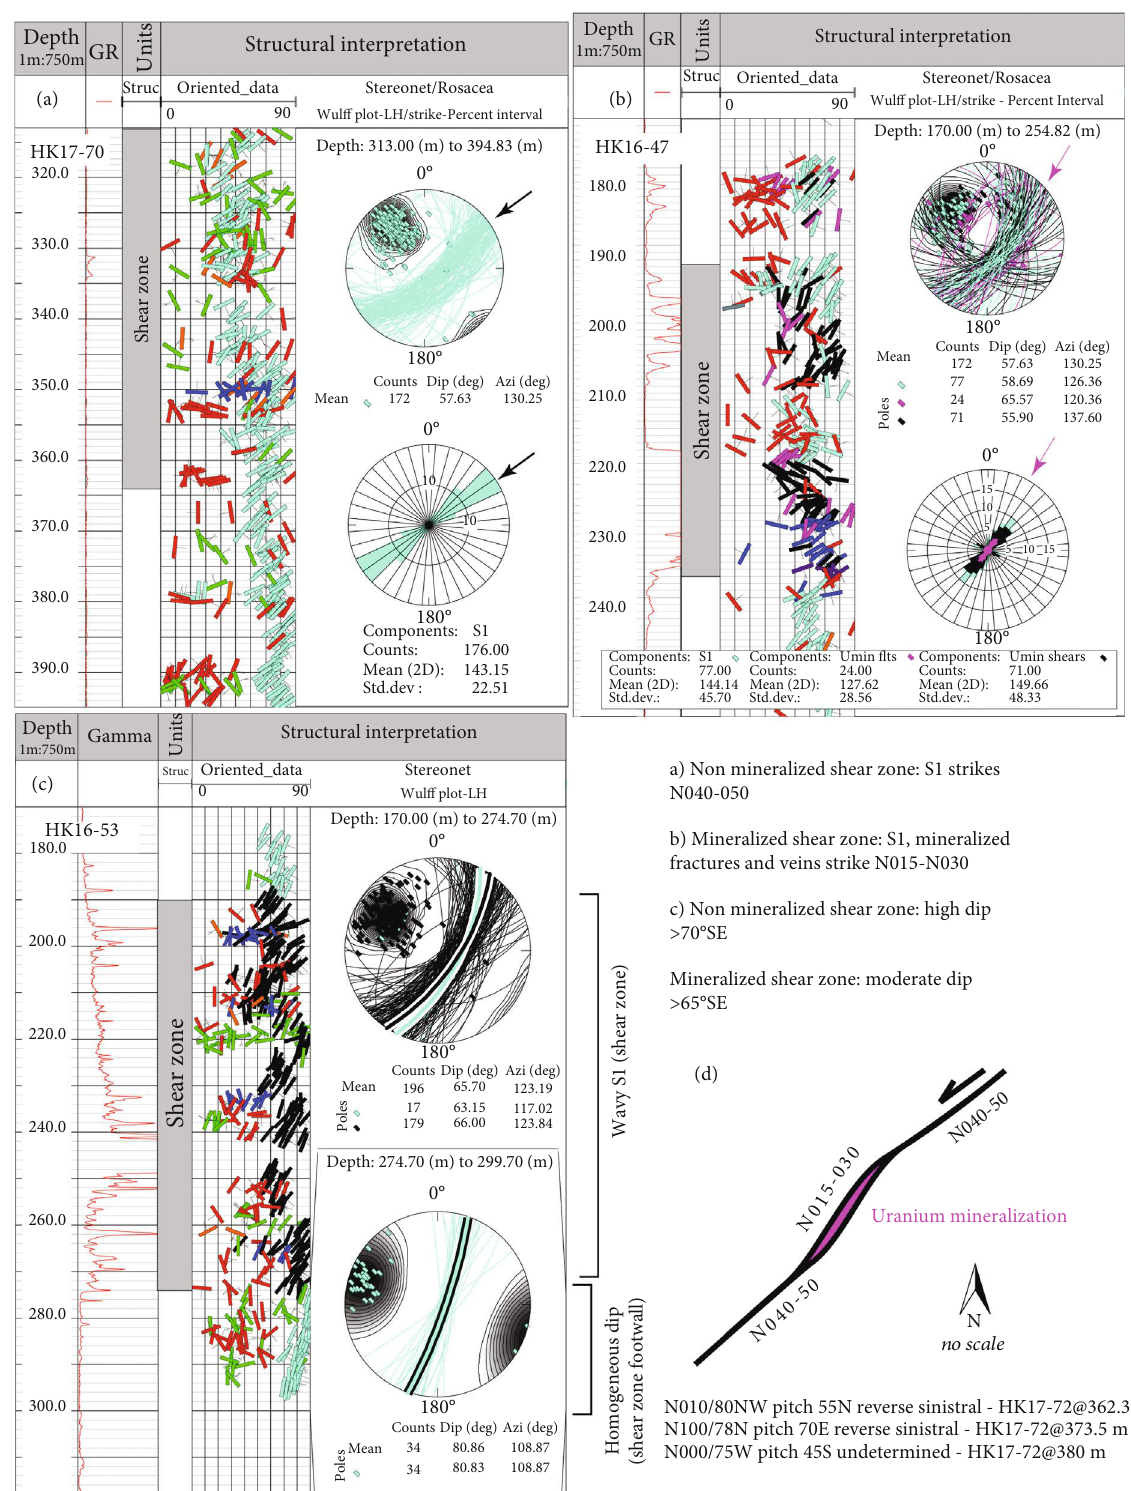
Figure 19: Comparison of the oriented data from ATV between nonmineralized and mineralized drill hole intervals in Spit fi re. (a) Oriented data from the nonmineralized drill hole HK17-70. (b) Oriented data from the mineralized drill hole HK16-47. Note the change in orientation of the shear zone indicted by the arrows. (c) Oriented data from mineralized drill hole HK16-53. Note the change of the dip from the shear zone to the footwall. (d) Sketch showing the structural interpretation as a dilational jog opening within which the mineralization is trapped. Oriented data from drill hole HK17-72 is